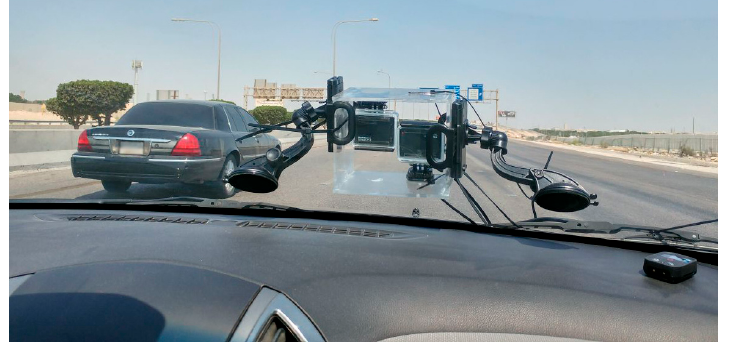
Figure 4. Example of the GoPro cameras recording for the first-person movie setup.